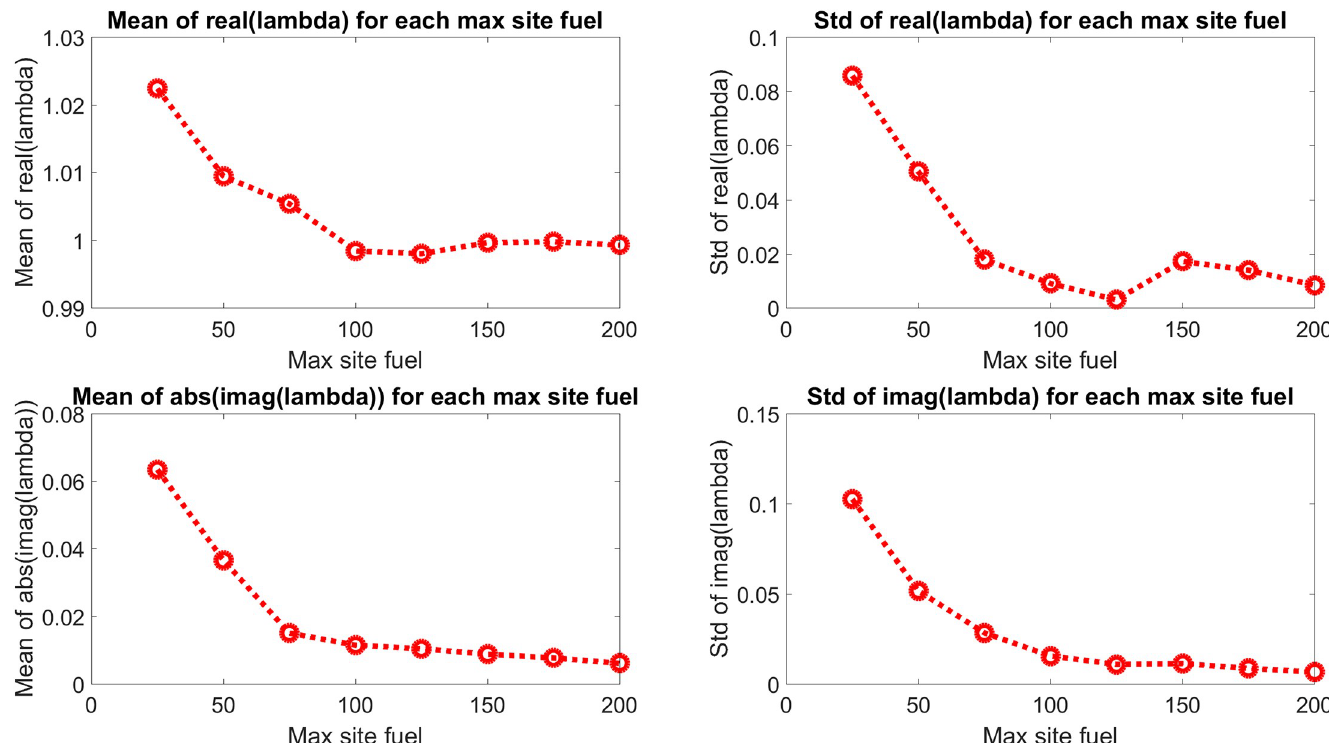
Fig 19. Mean and standard deviation of dominant mode eigenvalue components. The eigenvalues do not show a strong dependence on maximum site fuel value.